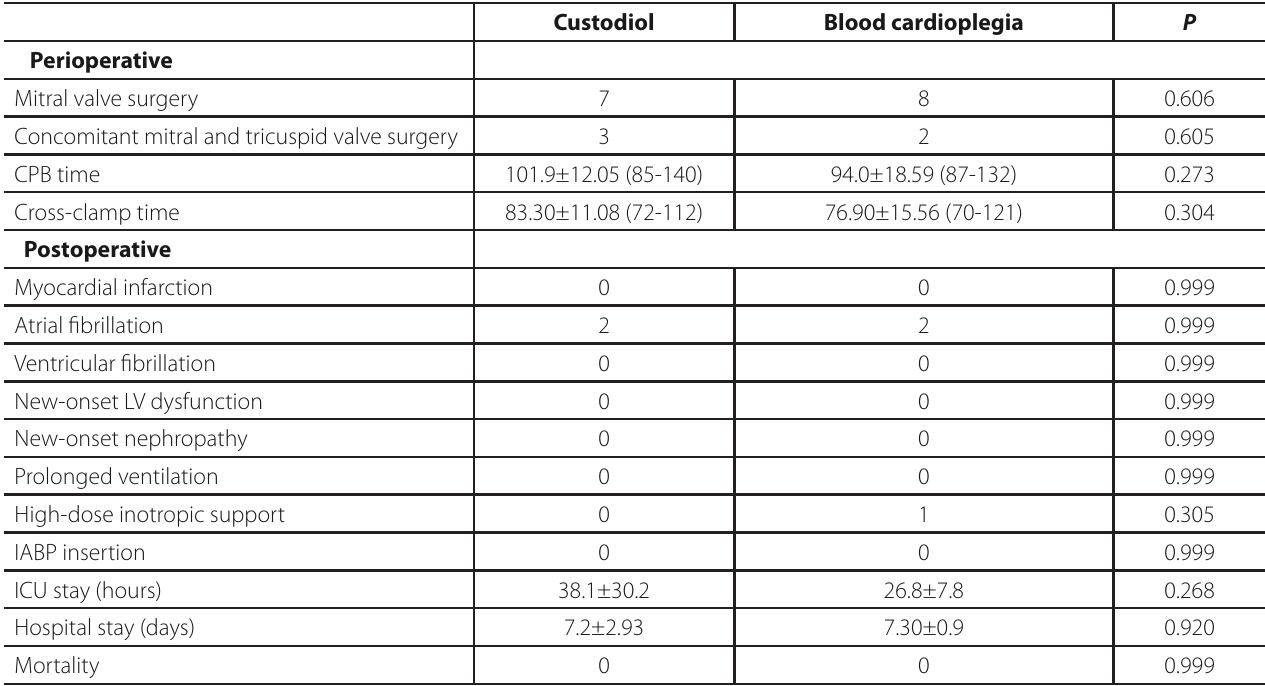
Table 3. Operative data.